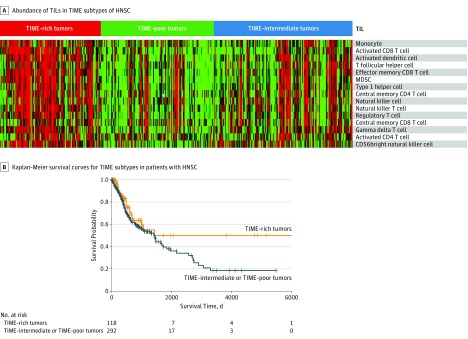
Abundance of Tumor-Infiltrating Lymphocytes (TILs) and Clinical Features of the Tumor Immune Microenvironment (TIME) SubtypesA, Heatmaps for other cancer types are shown in eFigure 2 in the Supplement. B, Kaplan-Meier survival curves of patients with the TIME-rich subtype and the combined TIME-intermediate and TIME-poor subtypes for head and neck squamous cell carcinoma (HNSC). The survival time for the patients with TIME-rich tumors was significantly longer than those with TIME-intermediate or TIME-poor subtypes. The curves for other cancer types are shown in eFigure 3 in the Supplement. CD4 indicates cluster of differentiation 4; CD56, cluster of differentiation 56; CD8, cluster of differentiation 8; and MDSC, myeloid-derived suppressor cell.